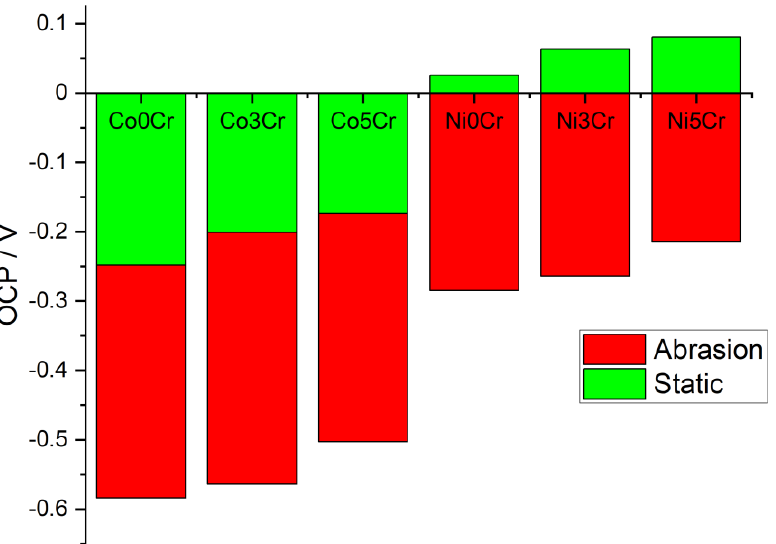
Figure 16. OCP values under static and abrasion conditions (mean values are reported on the plot, the standard deviation is always lower than 10